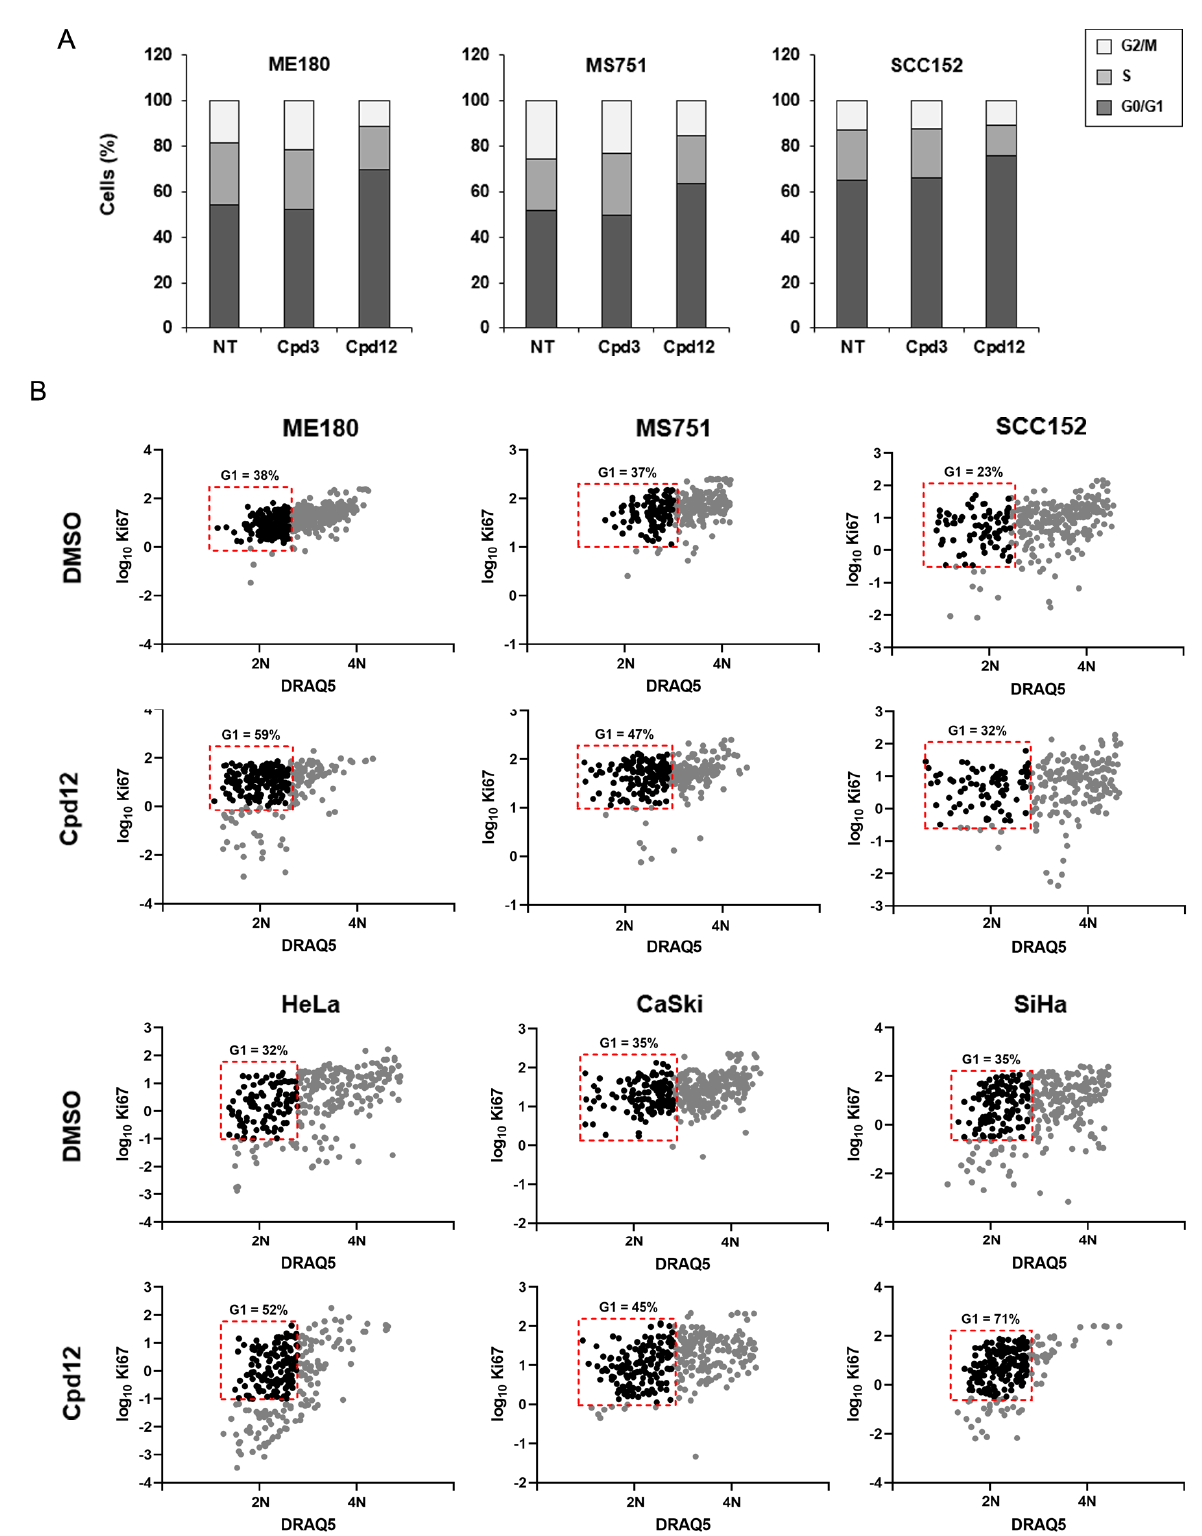
Figure 2. The cell-cycle arrest induced by Cpd12 occurs in the G1 phase. ( A ) The effects of Cpd12, the inactive small molecule Cpd3, or DMSO, on cell cycle modulation were evaluated by cytofluorimetric analysis of HPV-positive cervical (ME180 and MS751) and head-and-neck (SCC152) cancer cells treated for 24 h and then stained with PI. Bar graphs represent the percentage of cells in the different phases of the cell cycle (G0/G1, M, G2/S) as the mean of three independent experiments. ( B ) Cell-cycle distributions of HPV-positive cervical (ME180, MS751, HeLa, CaSki, and SiHa) and